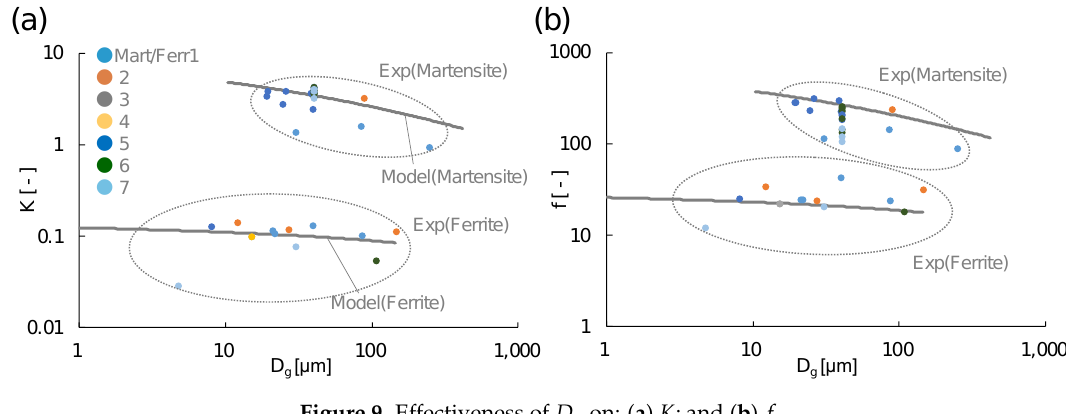
Figure 9. Effectiveness of D g on: ( a ) K ; and ( b ) f .